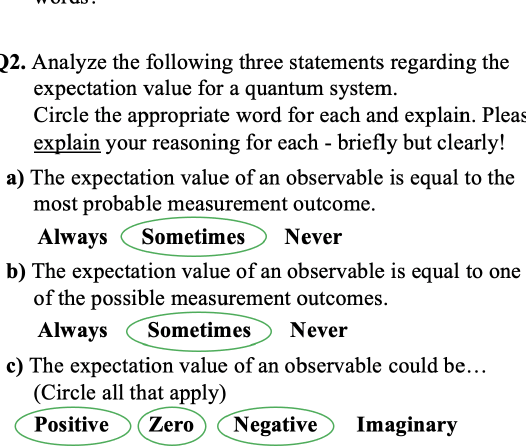
FIG. 1. Survey questions analyzed as part of this project. Correct responses to Q2 are circled.